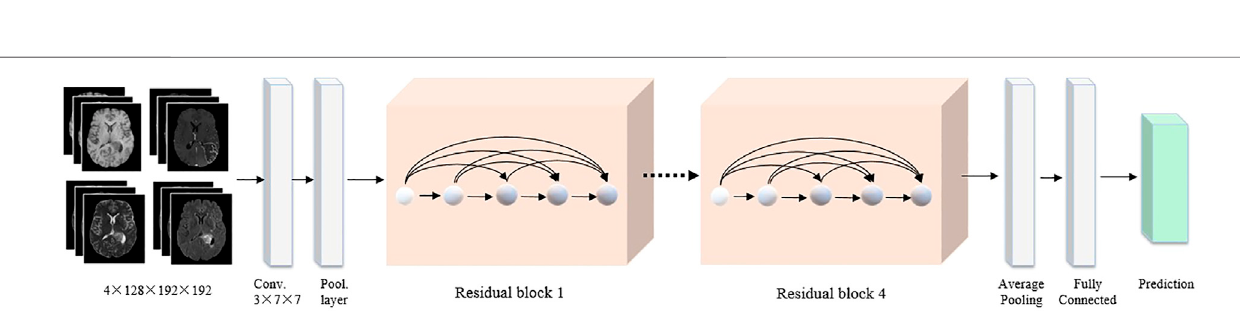
FIGURE 3 | The detailed 2D CNN network. The backbone includes Ef fi cientNet-B2, Ef fi cientNet-B3, and SE-ResNext101. In the fi nal feature representation, the meta-information (age) is included.